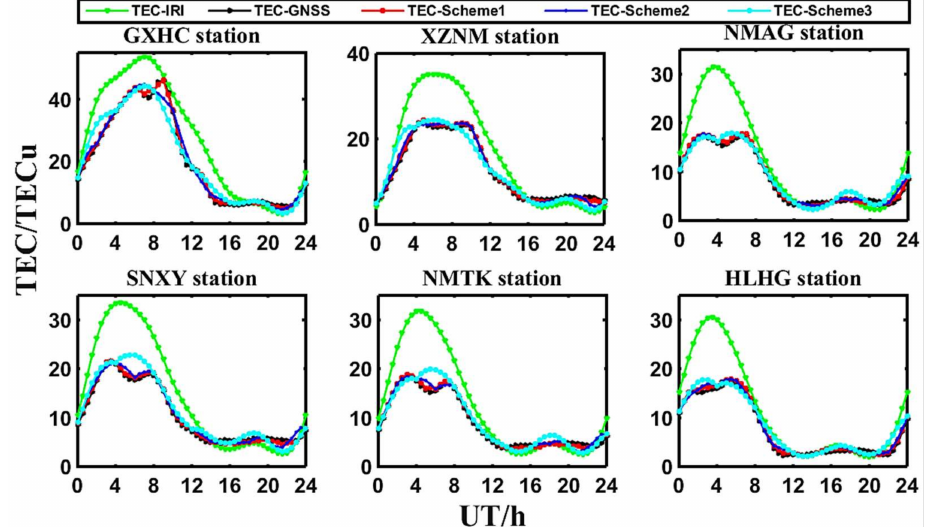
Figure 3. Comparison between TEC estimates corrected using different temporal interpolation schemes and GNSS-TEC at six receiver stations on the first day of 2015.